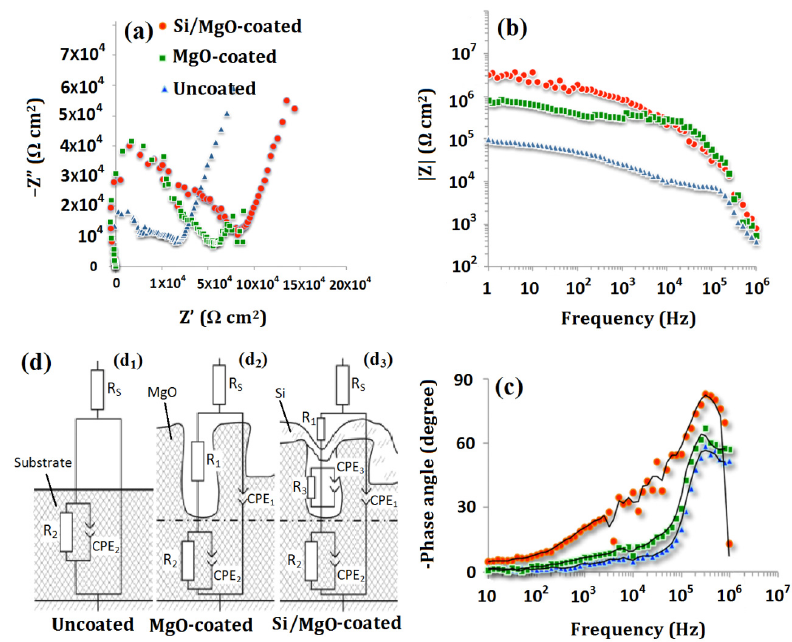
Figure 7. ( a ) Nyquist plots, Bode plots ( b ) impedance modulus vs. frequency plots and ( c ) phase angle vs. frequency plots for the uncoated, MgO ‐ coated, and Si/MgO ‐ coated in SBF solution; ( d ) The models vs. frequency plots for the uncoated, MgO-coated, and Si/MgO-coated in SBF solution; ( d ) The R–C Р E circuits).